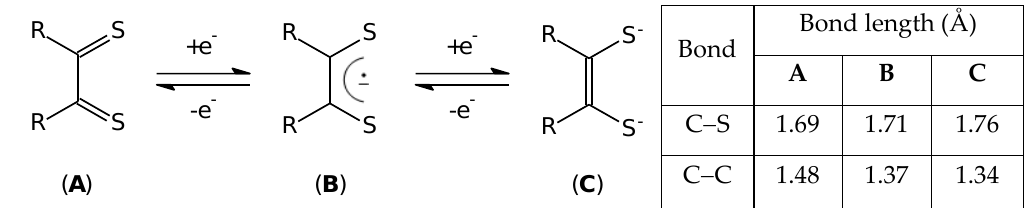
Scheme 2. Reversible redox processes of α -dithiones and typical bond distances on the C 2 S 2 moiety